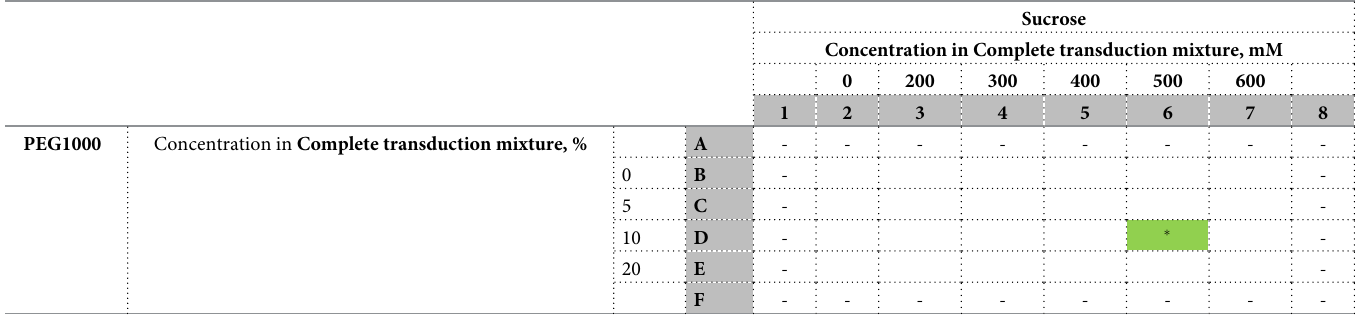
Table 8. Sucrose and PEG1000 concentrations optimization during standard osmotic lysis of pinocytic vesicles technique (48-well transduction plate layout).